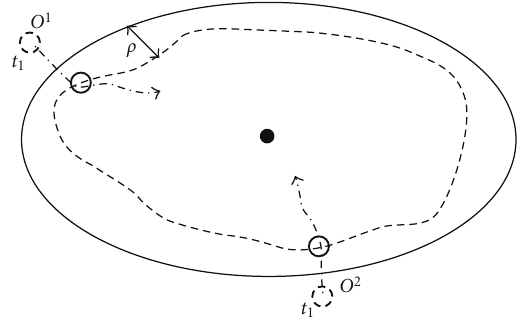
Figure 13: Illustration of the e ff ect of modeled region accuracy in association